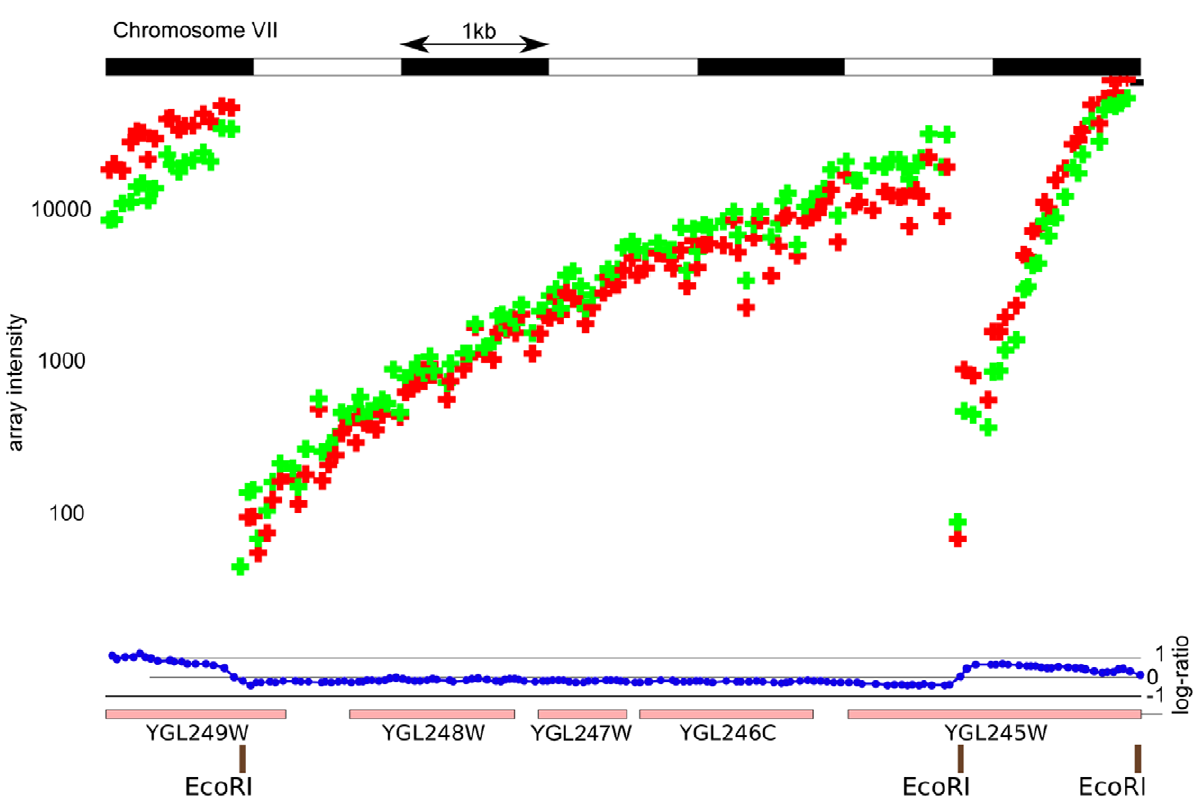
Figure 2. Log-intensities from a ruler array experiment over part of chromosome VII demonstrate the log-linear decrease in observed array intensity as distance increases from the restriction site. The red marks indicate probe observations from the S288c channel and the green marks indicate observations from the S 1278b channel. Note the similarity between the channels (blue marks towards bottom show the ratio between channels) and the relatively log-linear fall off between the restriction sites (brown tick marks at bottom). Note that the intensities are highest over the restriction sites (tick marks at bottom) and fall off roughly linearly.